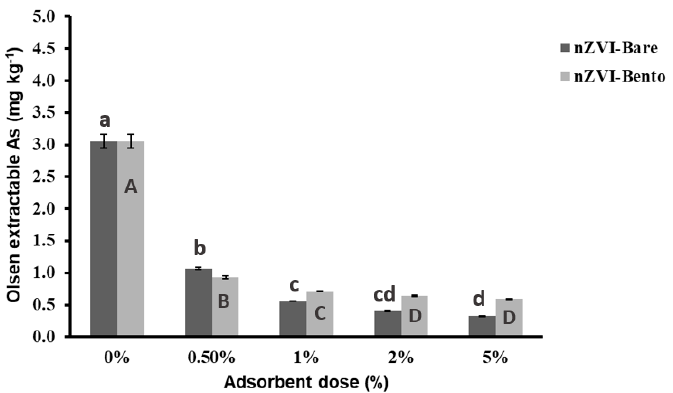
Figure 7. Effect of dose of ZVI products on Olsen extractable As content (mg kg − 1 ) of As-contaminated soil collected from Mitrapur, West Bengal. Different lowercase letters denote a significant difference among the values across the treatments in nZVI-Bare, while different uppercase letters denote significant difference for nZVI-Bento treatments.